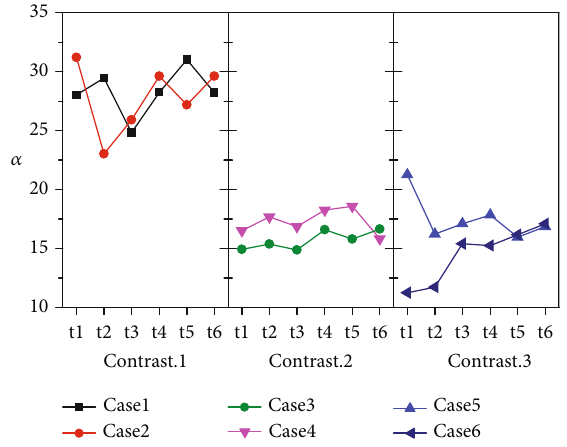
Figure 15: Comparative results of the de fl ection angle of the icing stagnation point.